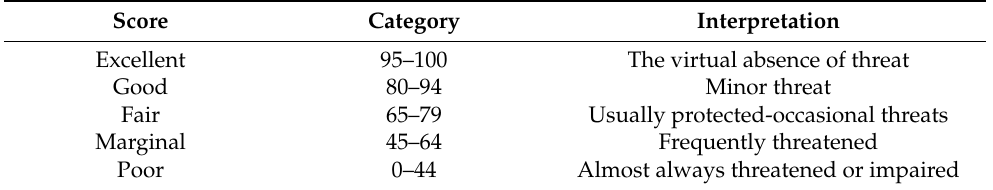
Table 1. Interpretation of the scores of the CCME